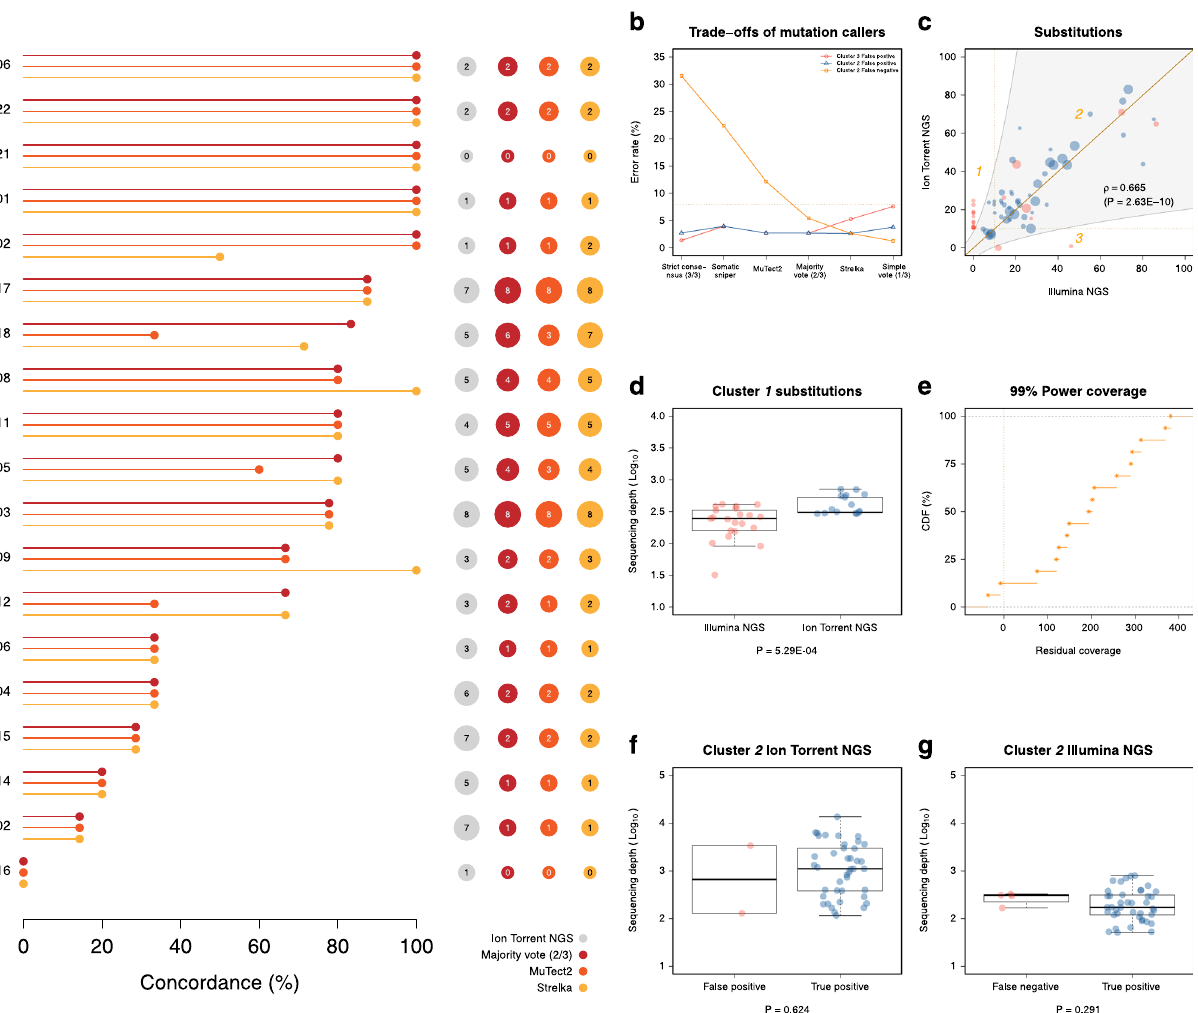
Fig. 3 Orthogonal cross-testing of substitution calls using Illumina NGS. a distribution of % concordance for single nucleotide substitutions indexed from the Ion Torrent and Illumina NGS platforms using different mutation callers, b % error rate of the different mutation callers over three substitution clusters compared to the Ion Torrent sequencing, c correlation of VAF for substitutions indexed from the Ion Torrent and Illumina NGS using a majority rule of any two of three mutation callers, d comparison of sequencing coverage between the Ion Torrent and Illumina NGS for substitutions in cluster 1 , e empirical cumulative distribution of theoretical residual coverage from the Illumina sequencing for substitutions in cluster 1 and cluster 2 false negatives, f comparison of sequencing coverage from the Ion Torrent NGS for substitutions in cluster 2 false positives, and g comparison of sequencing coverage from the Illumina NGS for substitutions in cluster 2 false negatives. In a , the different mutation callers and any combination thereof are colour coded and indicated at the bottom. The leftmost panel gives the number of substitutions called. In b – g , the cluster numbers are relative to ( c ). Substitutions in clusters 1 and 3 are exclusive to one of the sequencing platforms and have 0% VAF in the alternate data. Substitutions in cluster 2 are those found by either or both NGS platforms and have non-zero VAF in both sequencing data. False negatives in cluster 2 are substitutions indexed by Ion Torrent NGS only whilst false positives are substitutions indexed by Illumina NGS only using a given mutation caller or any combination thereof. The size of each dots is proportional to the difference in coverage between the two sequencing platforms. In e , the residual coverage is obtained by subtracting the theoretical coverage required to achieve 99% power for indexing a substitution given one mutated copy out of n total copies from the observed value of sequencing depth. Only two substitutions in cluster 1 failed the criteria of positive residual for detection and are non-callable